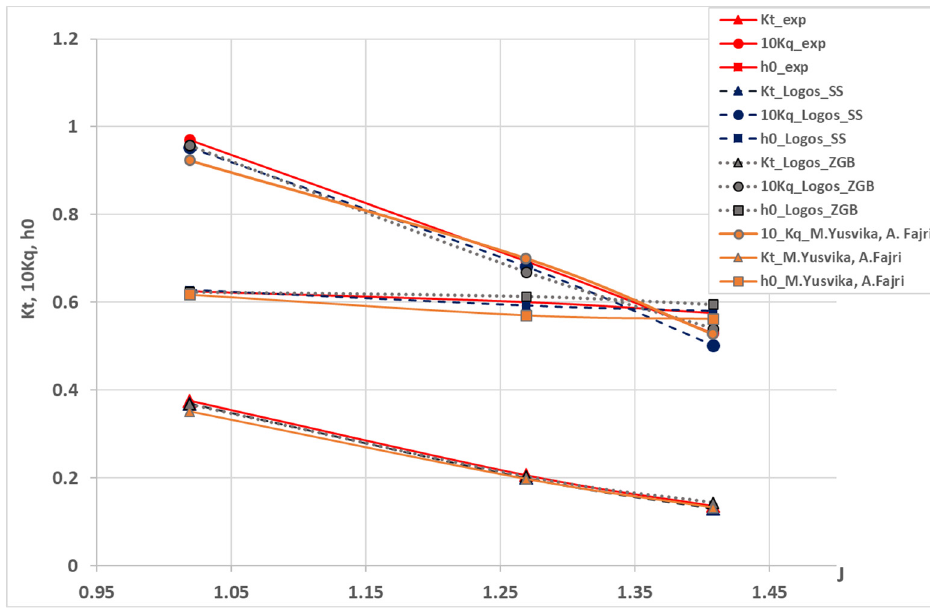
Figure 7. The VP1304 propeller performance curves under cavitation conditions.